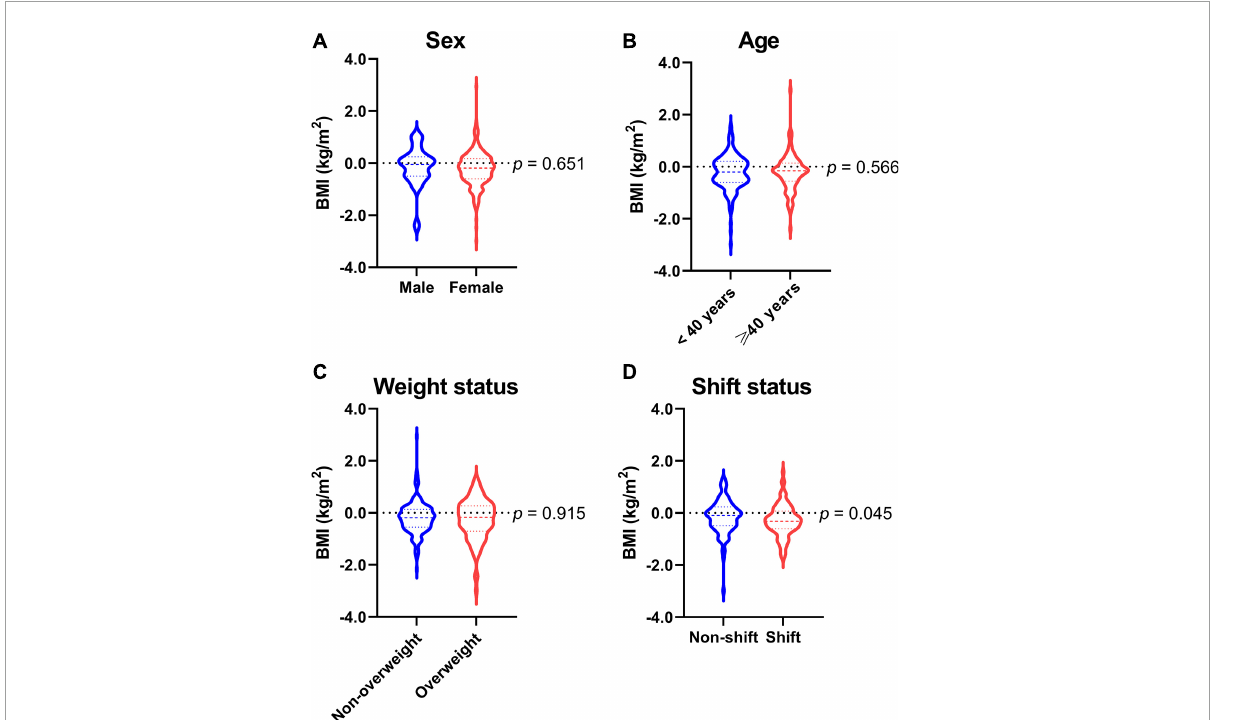
FIGURE3 Response differences in body mass index of (A) sex subgroups, (B) age subgroups, (C) weight status subgroups, and (D) shift status subgroups. BMI, body mass index. Data are summarized as medians, quartiles, and ranges (violin plots) and compared using generalized estimating equation analyses adjusted for age, profession, and shiftwork status.